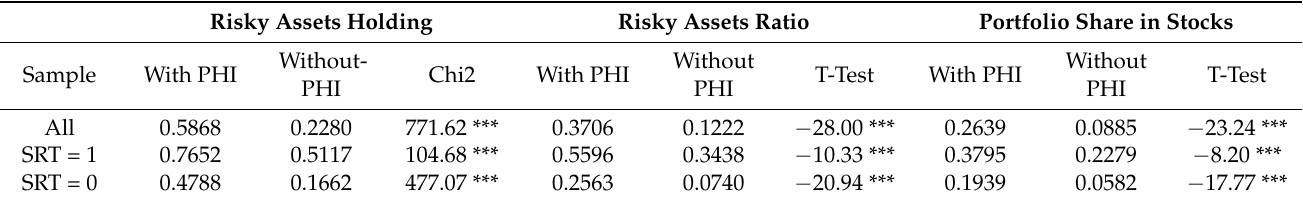
Table 3. The average values of risk taking with private health insurance and Subjective risk taking (SRT). Risky Assets